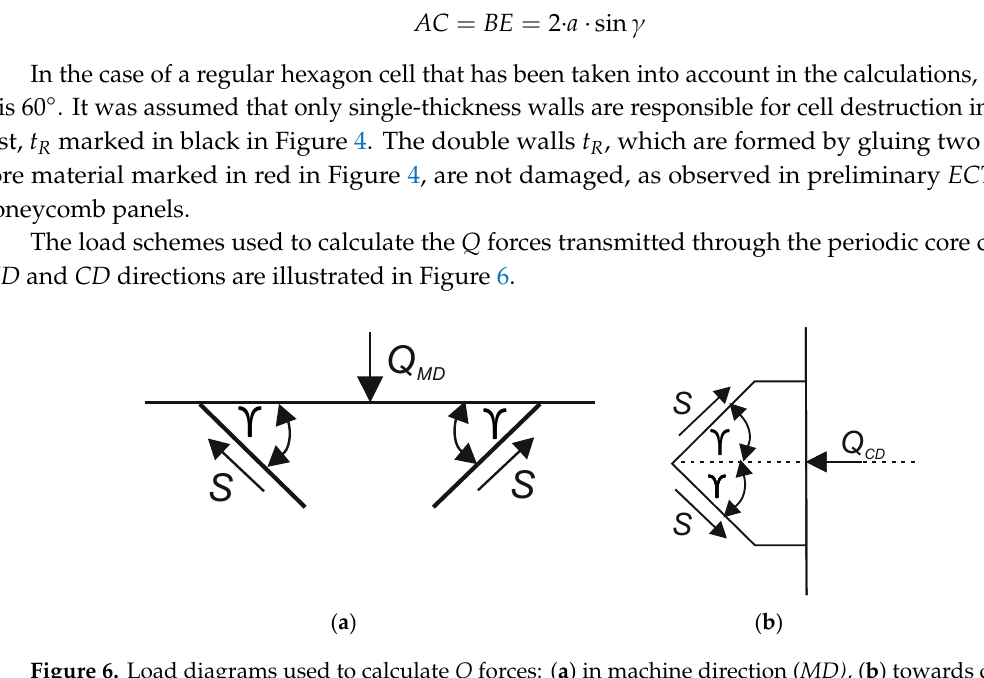
Figure 6. Load diagrams used to calculate Q forces: ( a ) in machine direction ( MD) , ( b ) towards cross direction ( CD) .